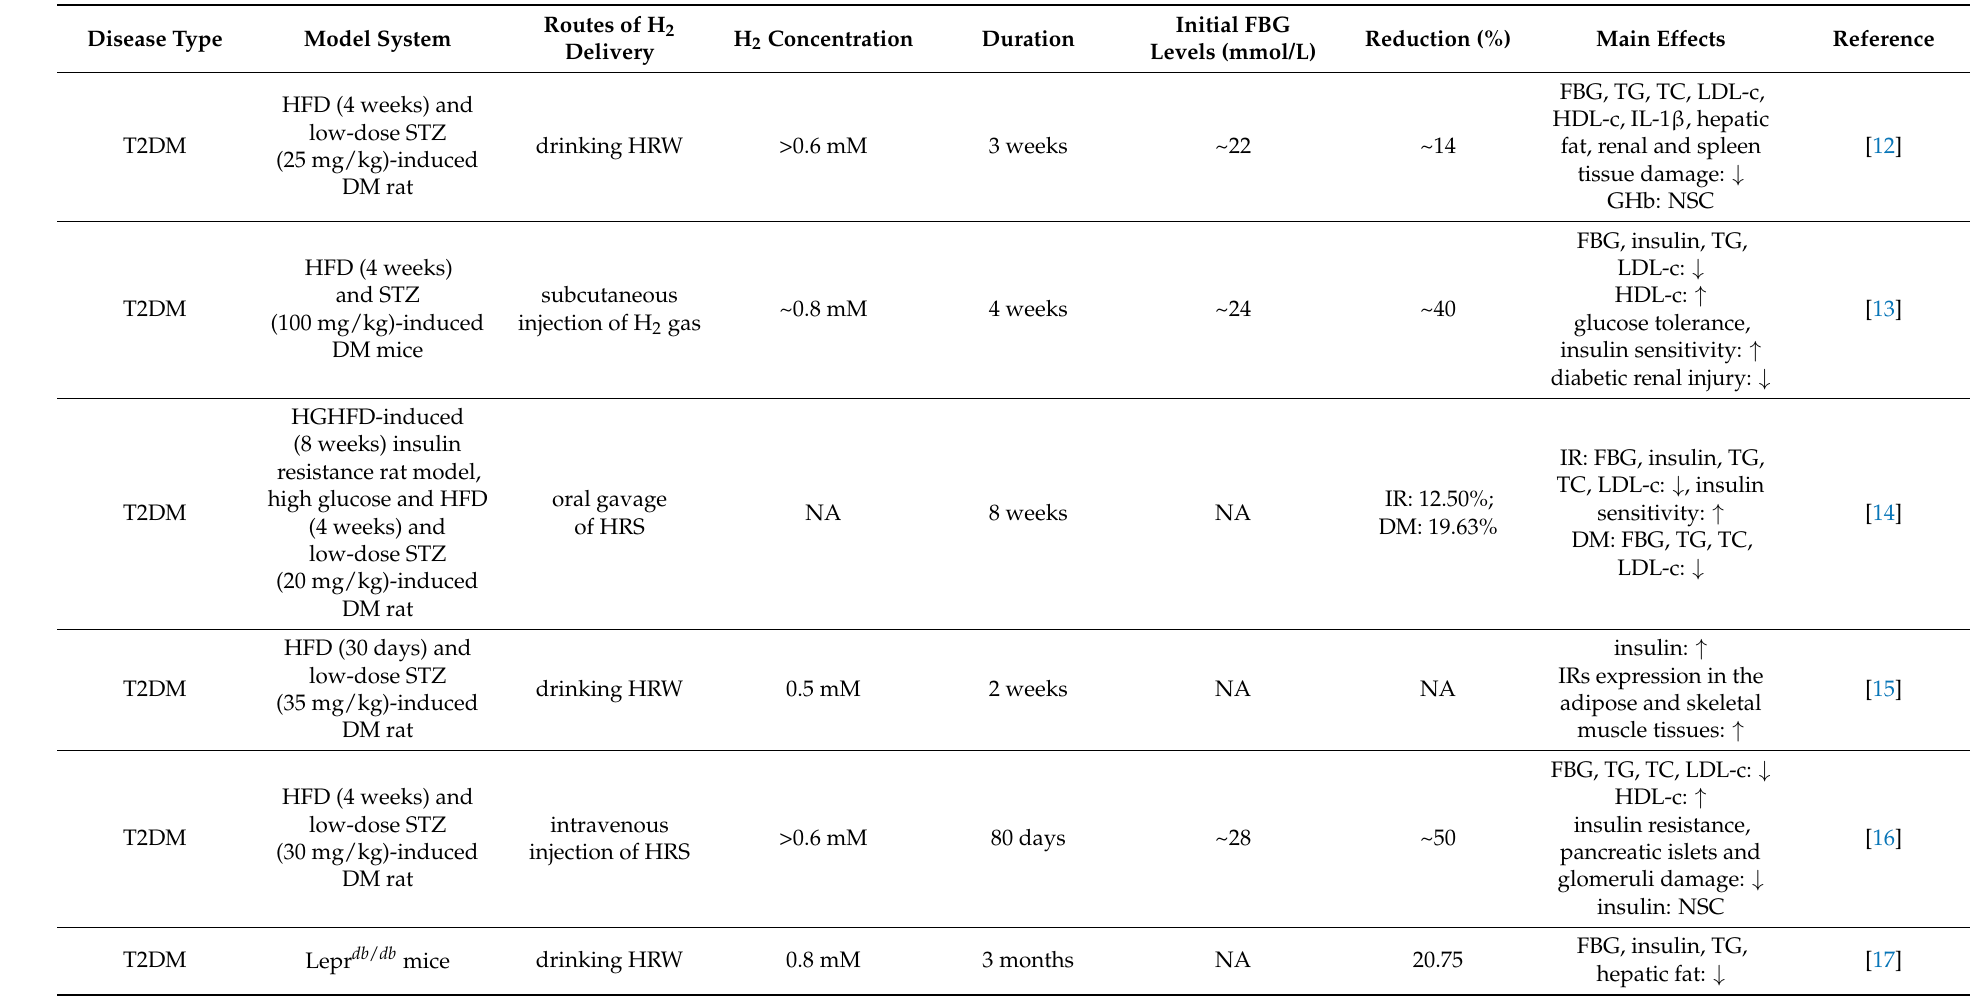
Table 1. The effects of H 2 intervention on